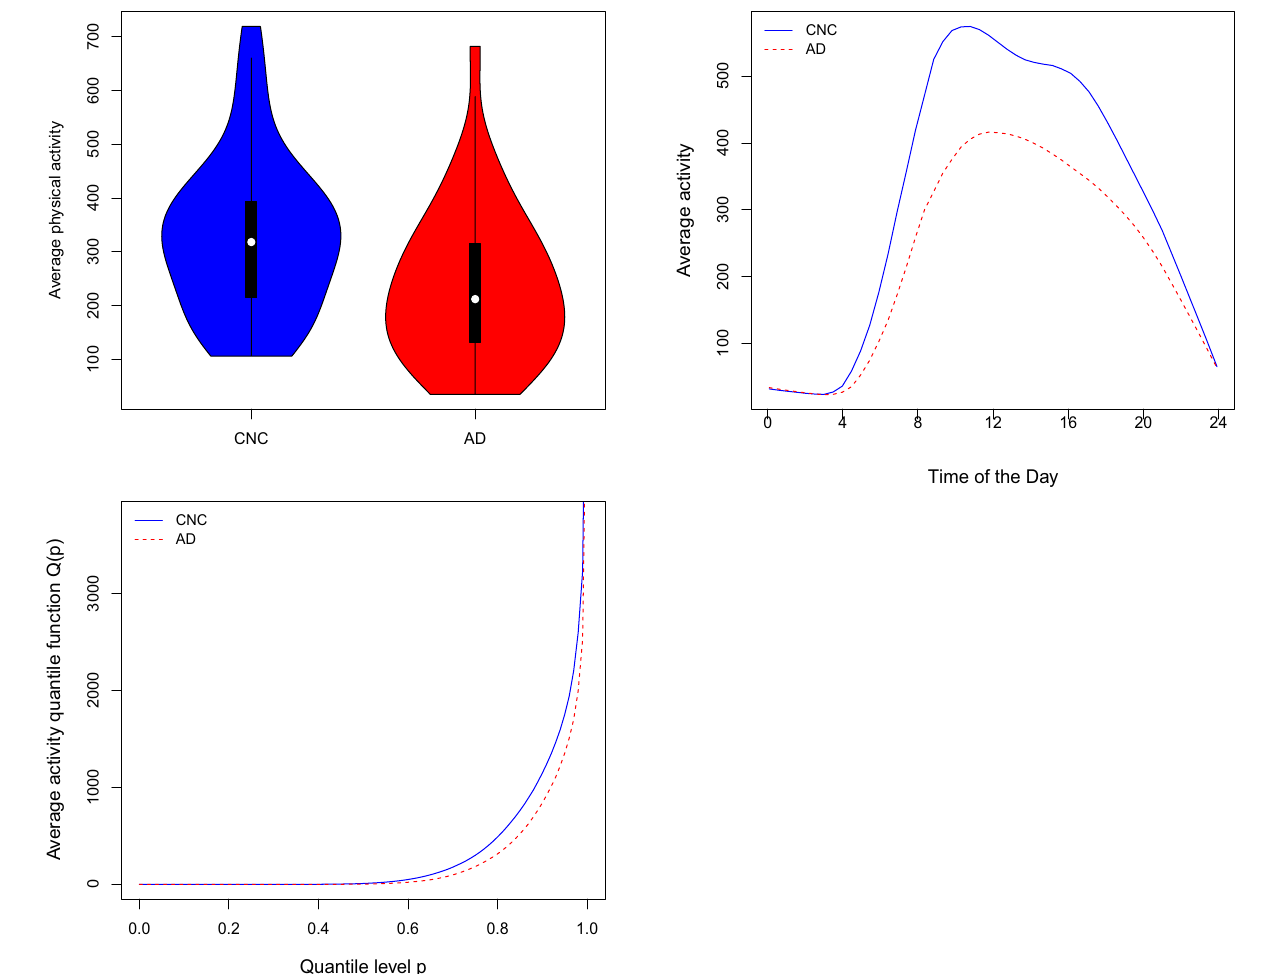
Figure 1. Top left: violin plot of subject-specific averages for CNC and AD participants. top right: smoothed diurnal activity profiles averaged across CNC (blue) and AD (red) participants. Bottom left: average quantile functions of physical activity for AD and CNC